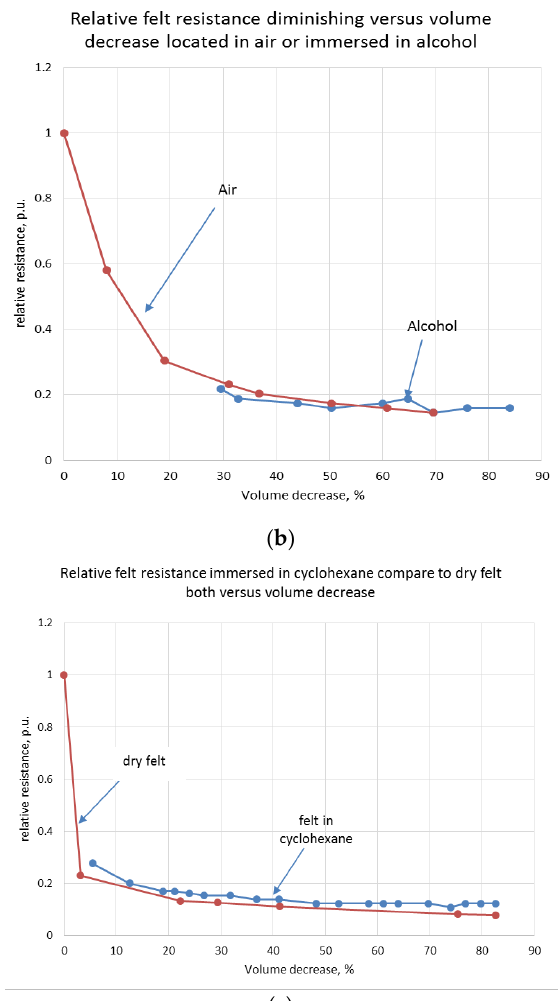
Figure 9. Relative resistance of a felt immersed in glycerol ( a ), alcohol ( b ) and cycloxane ( c ) versus volume compression. volume